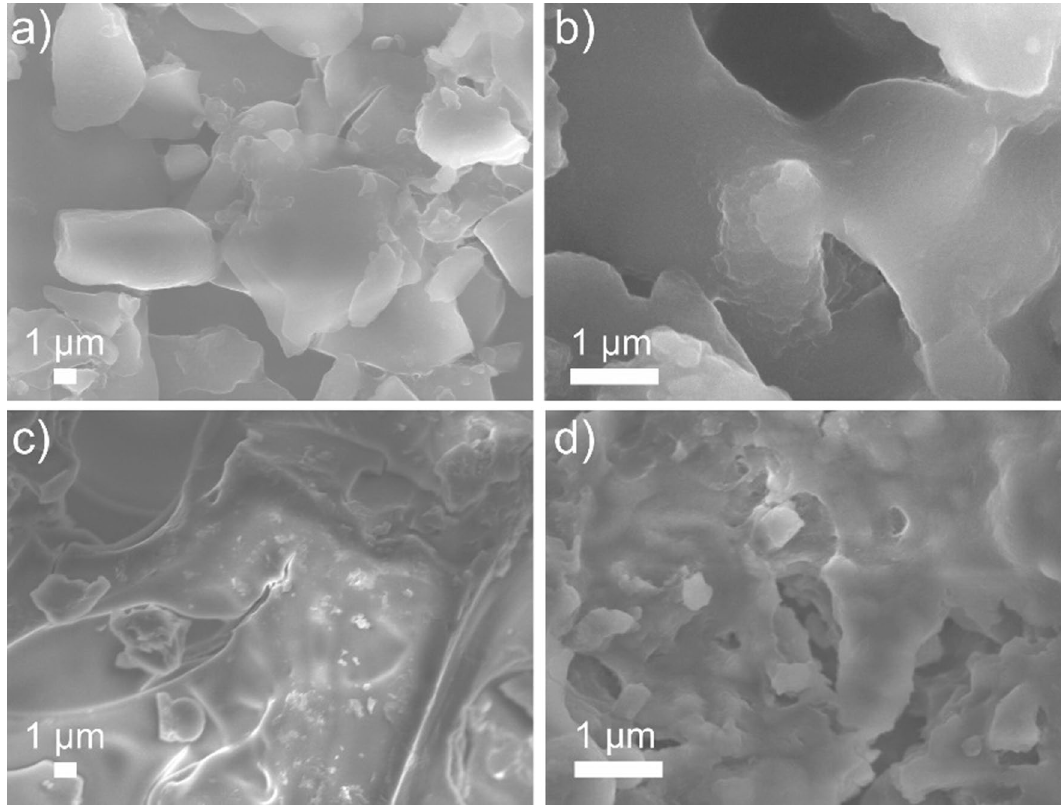
Figure 4. SEM images of ( a , b ) the products of 2-chloro-2-propen-1-ol oligomerization and ( c , d ) the products of norbornene